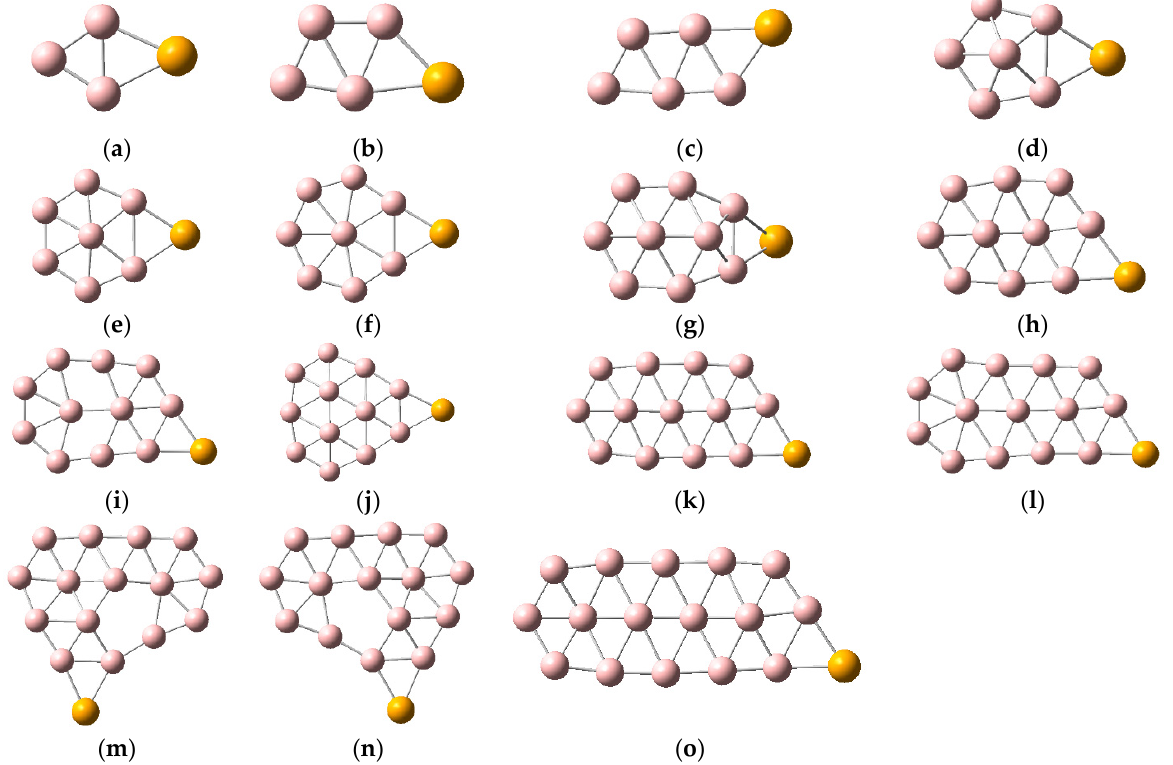
Figure 1. Structures of SeB n . ( a ) SeB 3 C 2V ; ( b ) SeB 4 Cs; ( c ) SeB 5 Cs; ( d ) SeB 6 Cs; ( e ) SeB 7 Cs; ( f ) SeB 8 C 2V ; ( g ) SeB 9 Cs; ( h ) SeB 10 ; ( i ) SeB 11 Cs; ( j ) SeB 12 Cs; ( k ) SeB 13 C 1 ; ( l ) SeB 14 Cs; ( m ) SeB 15 I C 1 ; ( n ) SeB 15 II C 1 ; ( o ) SeB 16 C 1 .